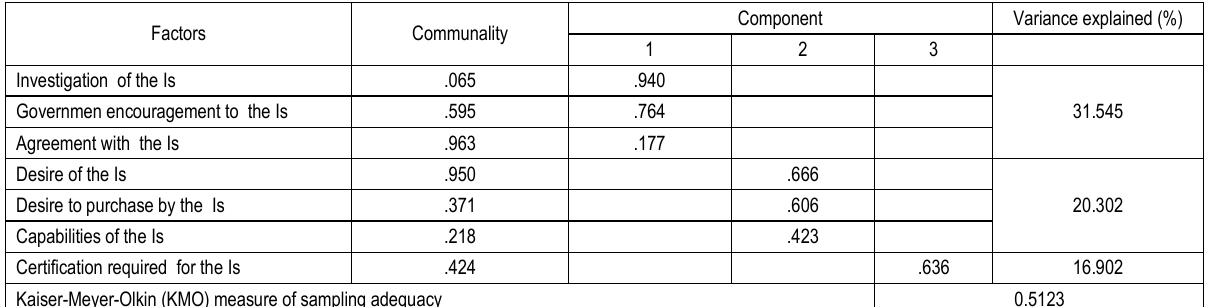
Table 8. Factor analysis (grade of the agreement or disagreement for financial institutions, NGOs